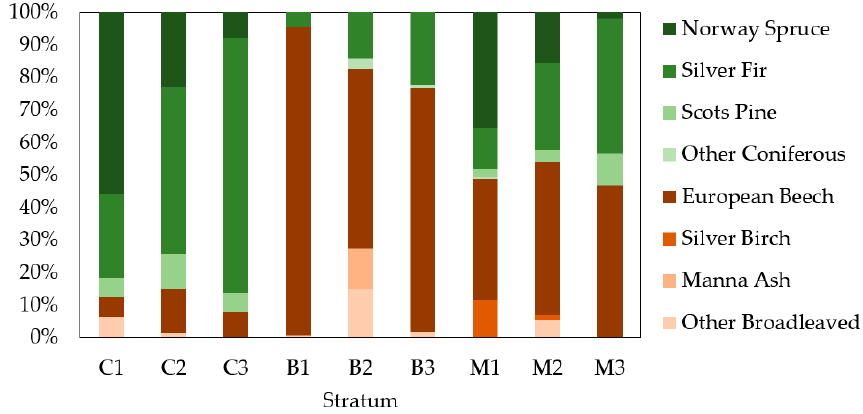
Figure 2. Tree species composition on plots related to number of trees. C1-3, B1-3, M1-3: three development stages of coniferous, broadleaved, and mixed strata.